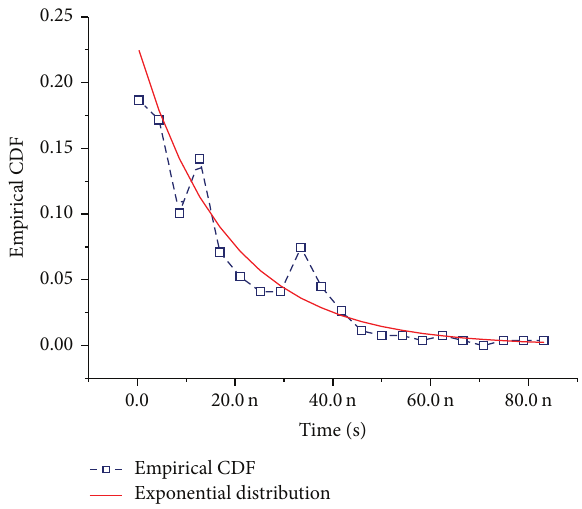
Figure 5: Empirical cumulative distribution and fitted exponential distribution of the excess delay of the first arrival at 2 GHz in Scenario